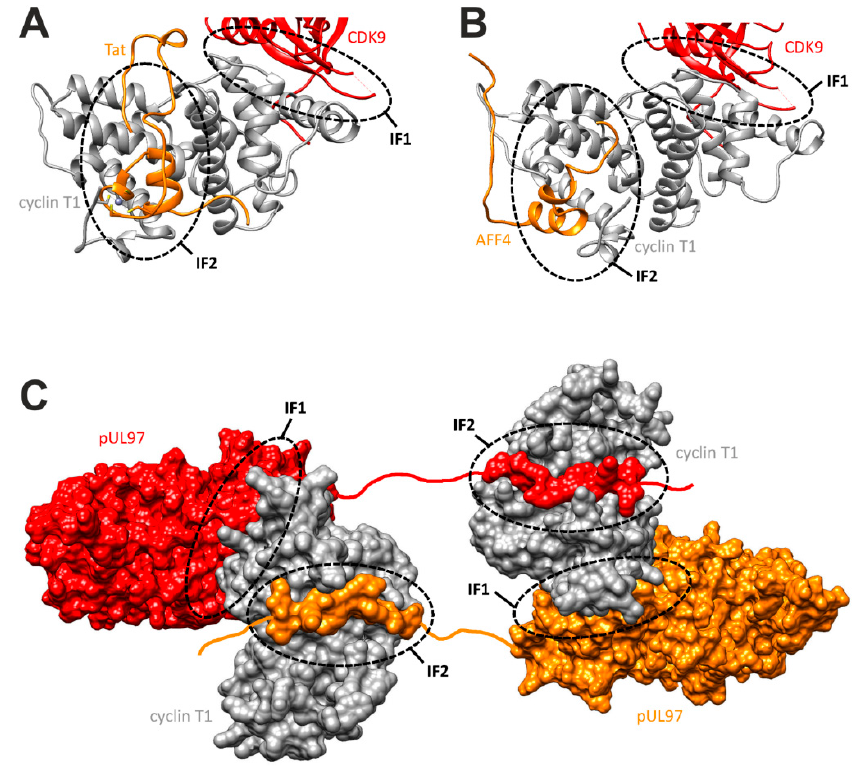
Figure 7. Cyclin T1 interaction sites and model of the cyclin T1–pUL97 complex. ( A ) Crystal structure of cyclin T1 (gray) with CDK9 (red) and Tat (orange). The two interfaces (IF1, IF2) used for these interactions are highlighted by dashed lines. ( B ) Crystal structure of cyclin T1 (gray) with CDK9 (red) and AFF4 (orange). ( C ) Model of a quaternary complex consisting of two pUL97 molecules (red, orange) bridged by two cyclin T1 domains (gray). pUL97(231–280) was modeled in an extended conformation in interface 2, whereas the globular pUL97 kinase domain was modeled to interface 1. Red and orange lines denote parts of the pUL97 structure for which no structural information is available.